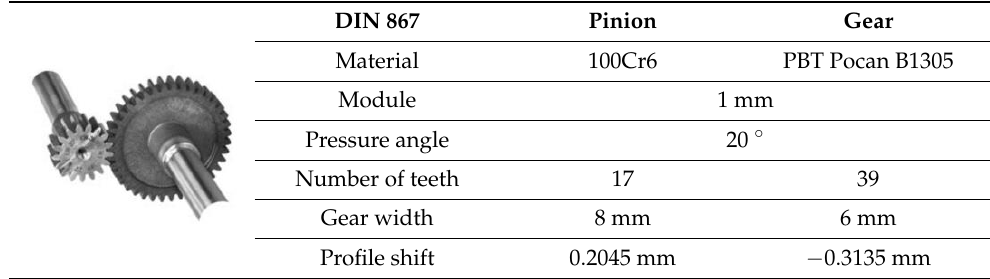
Table 1. Technical specifications of the investigated gear set.